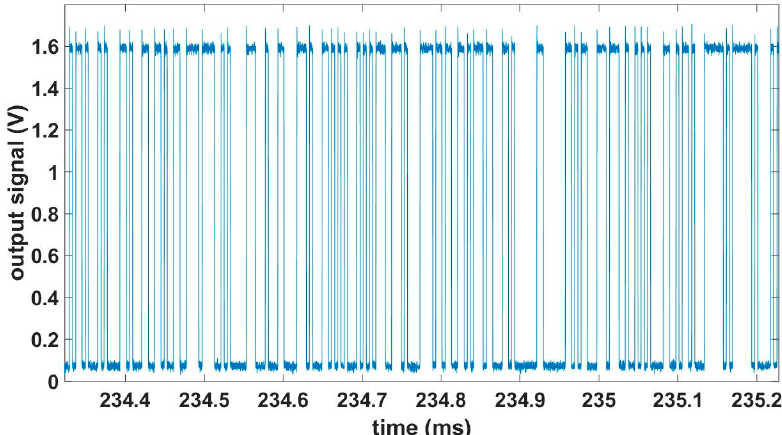
Figure 5. Sample signal obtained using a clock frequency of 31.25 kHz (in this case the throughput was 250 kHz ).